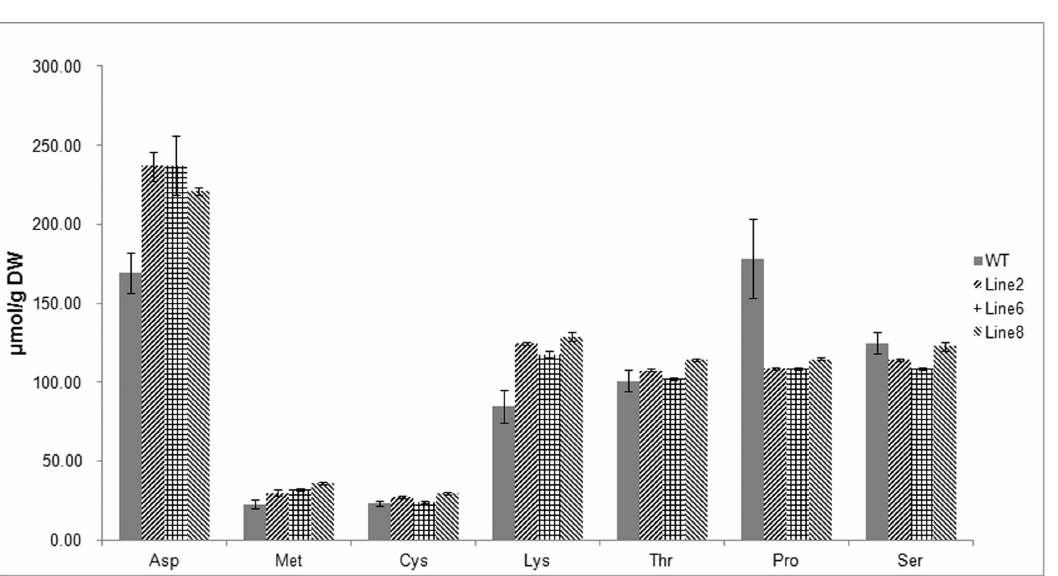
Figure 6. The content of crucial amino acids in leaves of wild-type and transgenic plants. Extracts were obtained from the leaves of 16- week-old non-transformed plants and transgenic plants co-expressing bacterial AK and APR . Seven kinds of crucial amino acids were list. The amounts of amino acids were calculated from dry weight of samples as detected by Hitachi L-8900 and are given in m mol/g DW. The data presented represent the mean and the bars represent 6 SE of three plants per line. doi:10.1371/journal.pone.0088310.g006 PLOS ONE |